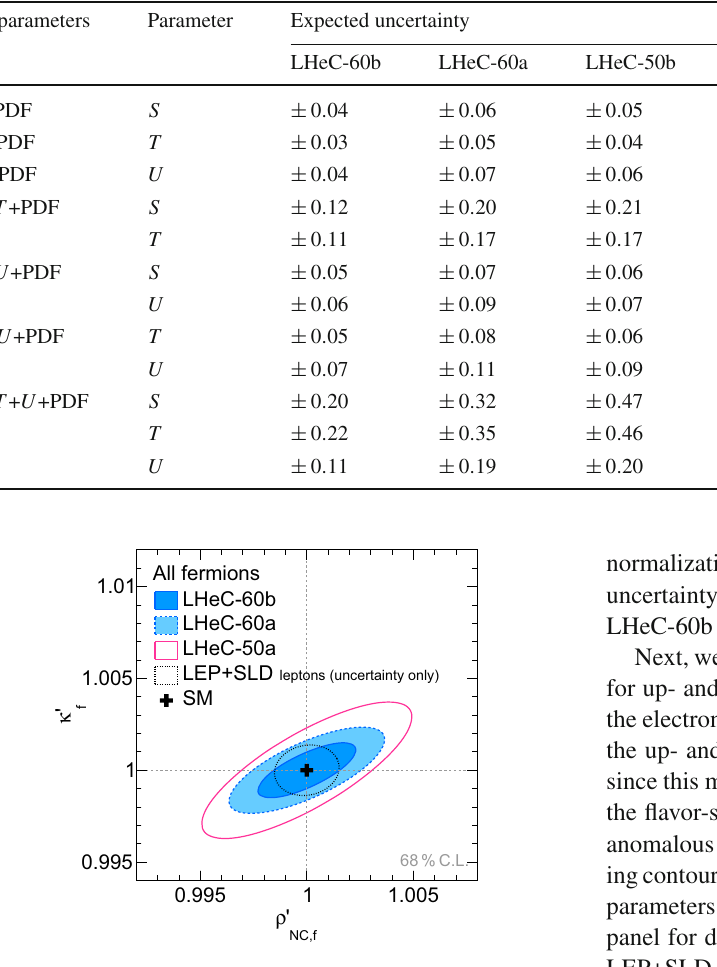
and κ (cid:9) at the 68% f NC , f